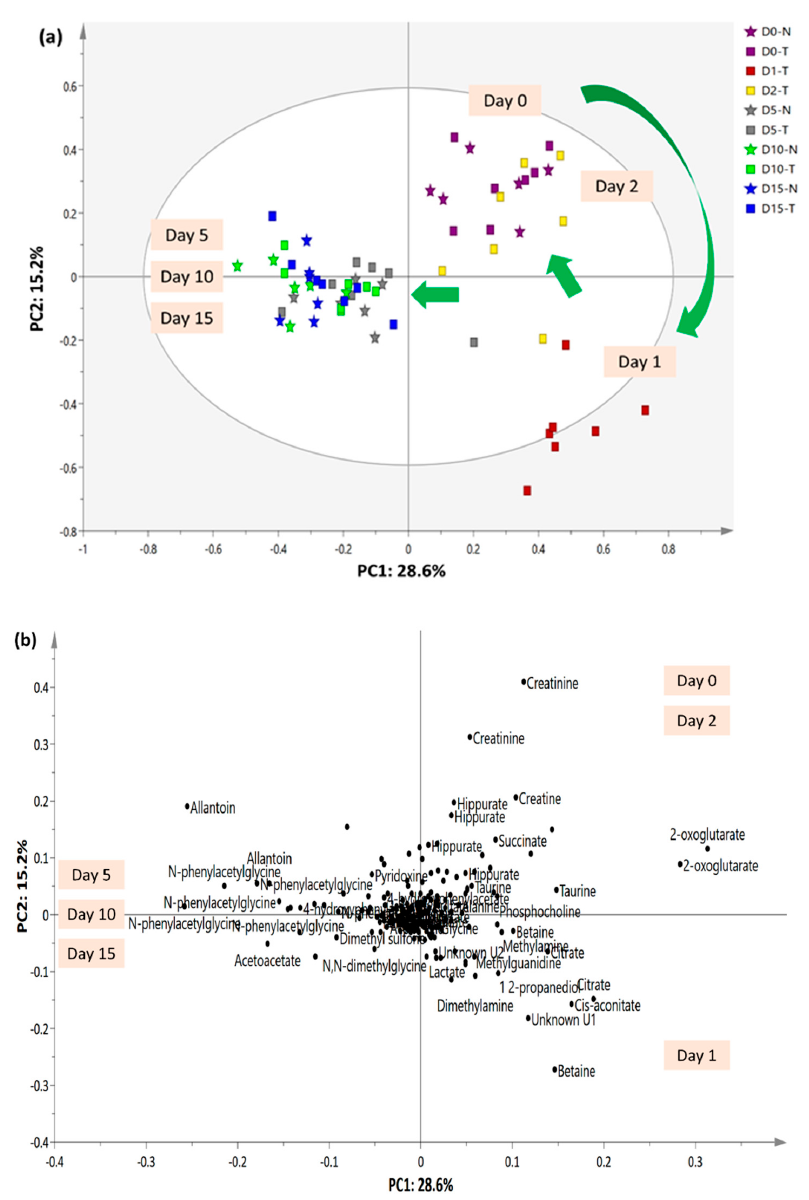
Figure 4. Principal component analysis (PCA) ( a ) score and ( b ) loading plots of urinary profiles trajectory trend of the untreated and treated groups collected on Day 0, 1, 2, 5, 10 and 15.